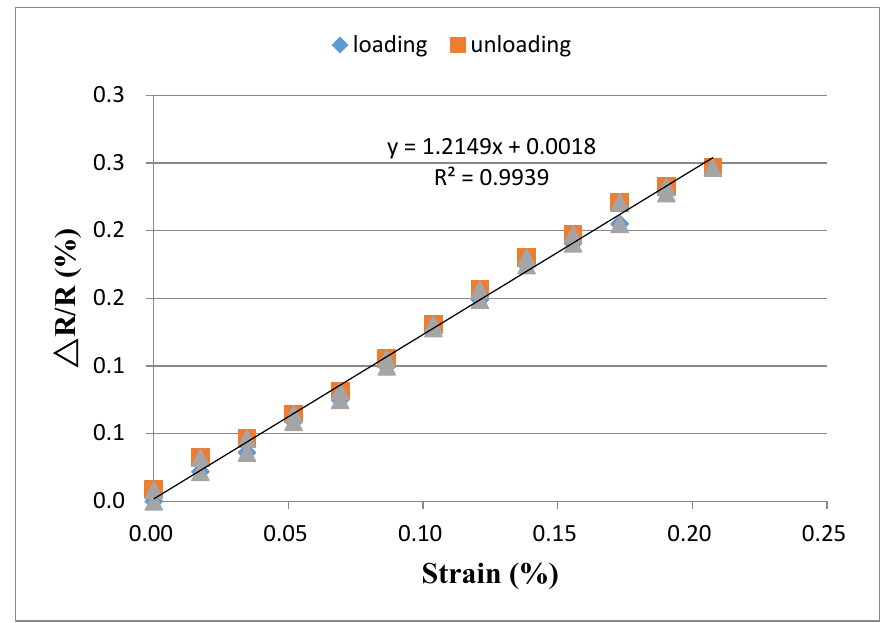
Figure 12. Relative resistance change vs. applied strain for the buckypaper made of high aspect ratio MWCNTs.